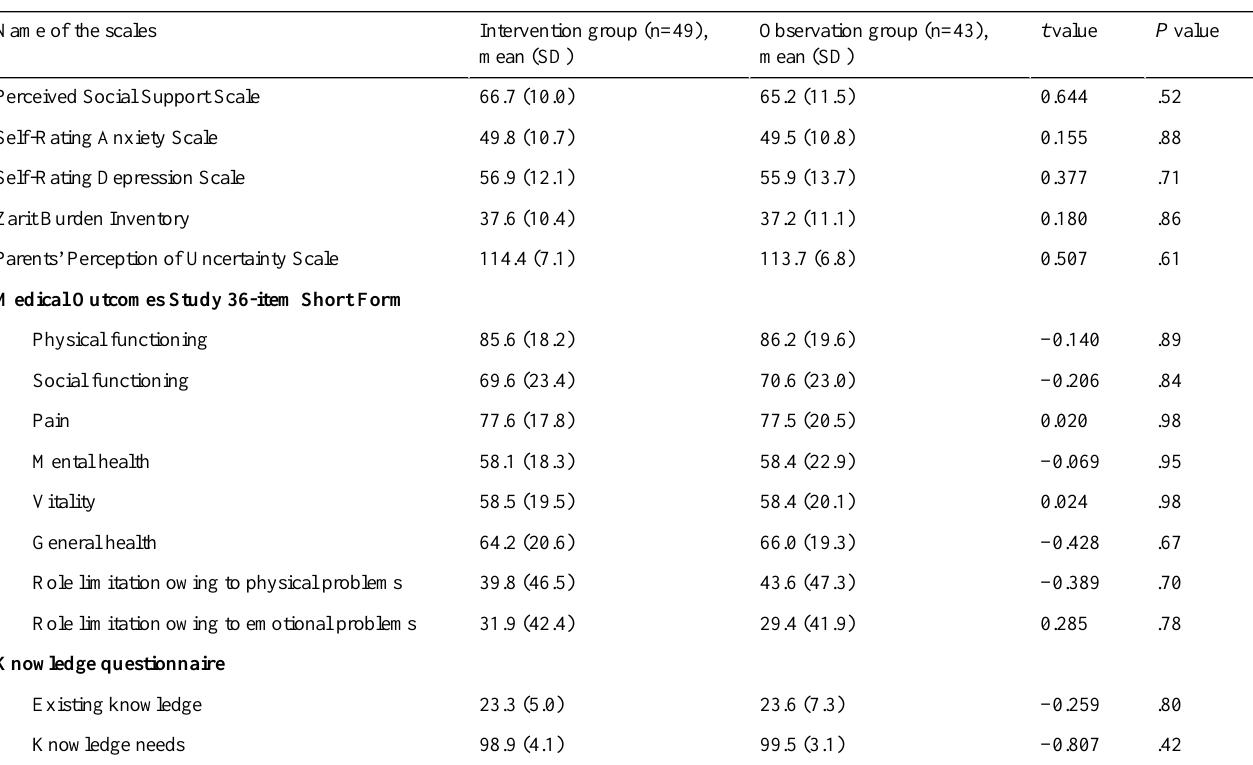
Table 1. The comparison of participants’baseline questionnaire results. (SD)Name of the